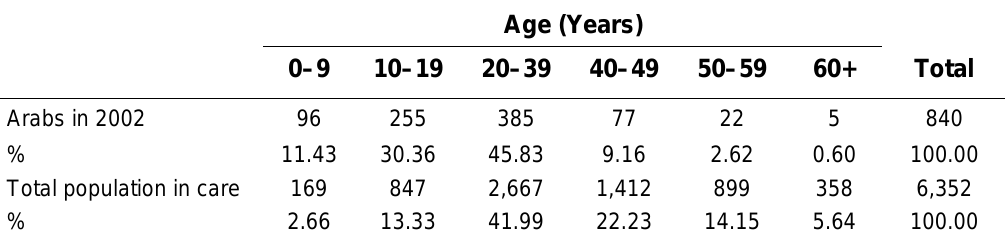
Age Distribution of Arab Persons with Intellectual Disability in Residential Care Centers in Israel Compared with Total Population in Care in 2002